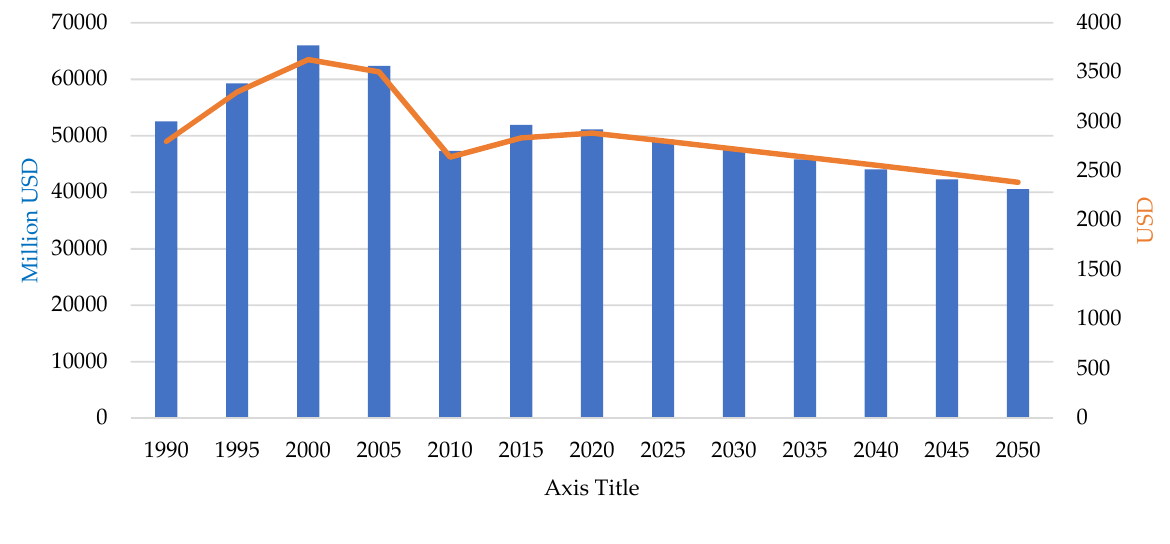
Figure 7. Change and prediction in the economic value of forest biomass carbon in Malaysia.